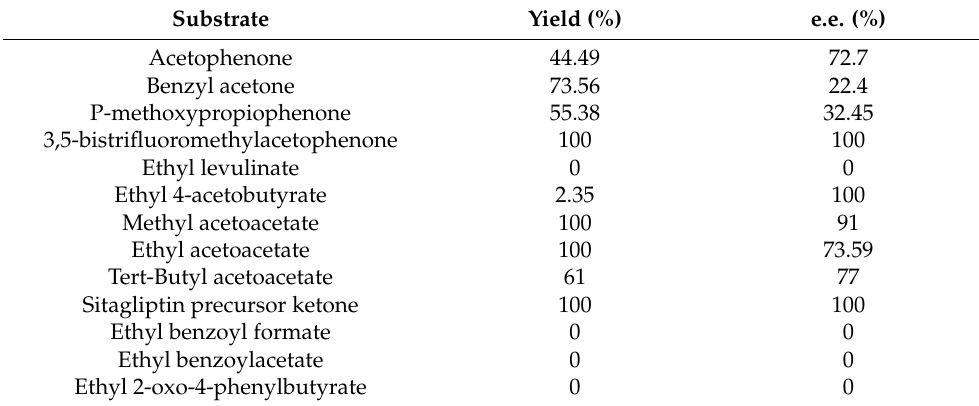
Table 3. Screening of substrate